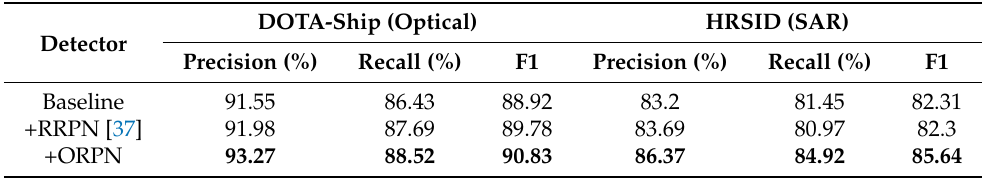
Table 3. Evaluation experiments for oriented region proposal network.